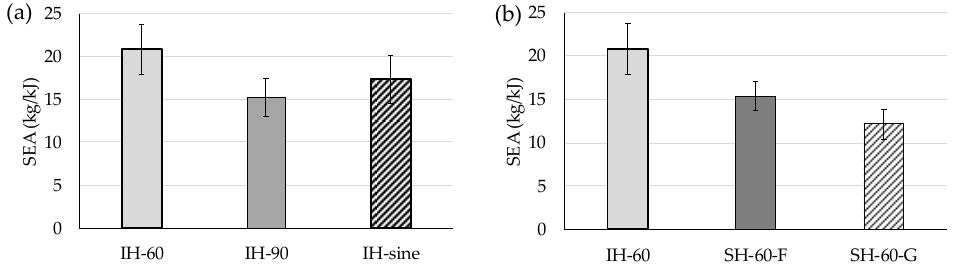
Figure 8. The average results of SEA for ( a ) webs having different frontal profiles and ( b ) webs having different stacking sequences.